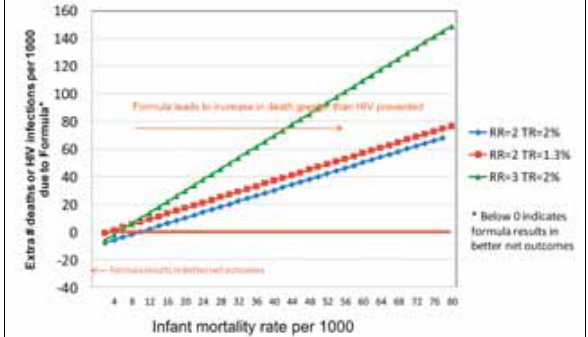
Fig. 1. Breastfeeding with ARVs results in better HIV-free survival when infant mortality rates exceed 10 per 1 000. The graph shows excess adverse outcomes (uninfected infant deaths or HIV infections) per 1 000 as a result of formula-feeding, compared with breastfeeding among HIV-infected women in populations of varying infant mortality rates. The models allow a transmission rate (TR) of 2% assuming ARVs are given and a best-case scenario of 1.3%, consistent with the Botswana clinical trial 22 of which 0.3% were due to breastfeeding acquired infections. The model assumes a relative risk (RR) of 2 which is consistent with best-case scenario of clinical trial-supported formula feeding in a better-off environment 5 and considers RR=3 more likely to represent the programmatic setting. All values >0 indicate that breastfeeding results in better net outcomes; values <0 indicate that formula-feeding results in better net